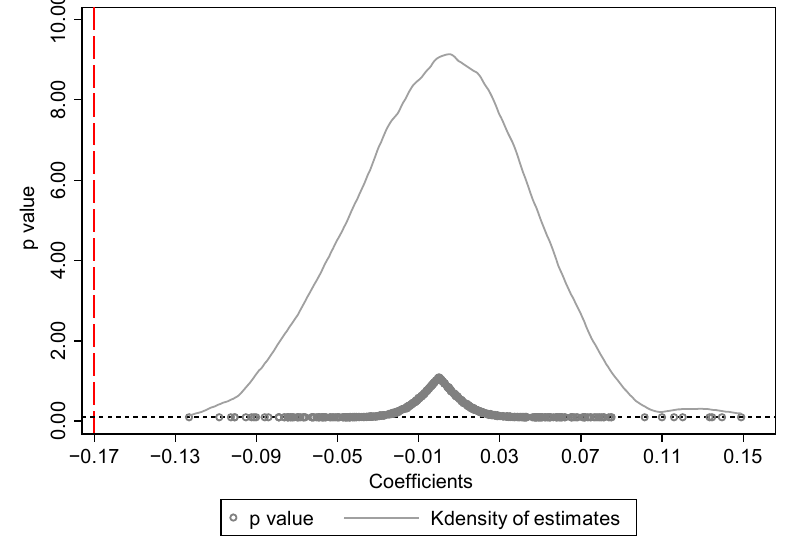
Figure 4. Placebo test.